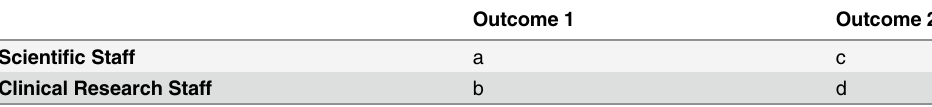
Table 1. Sample OR contingency